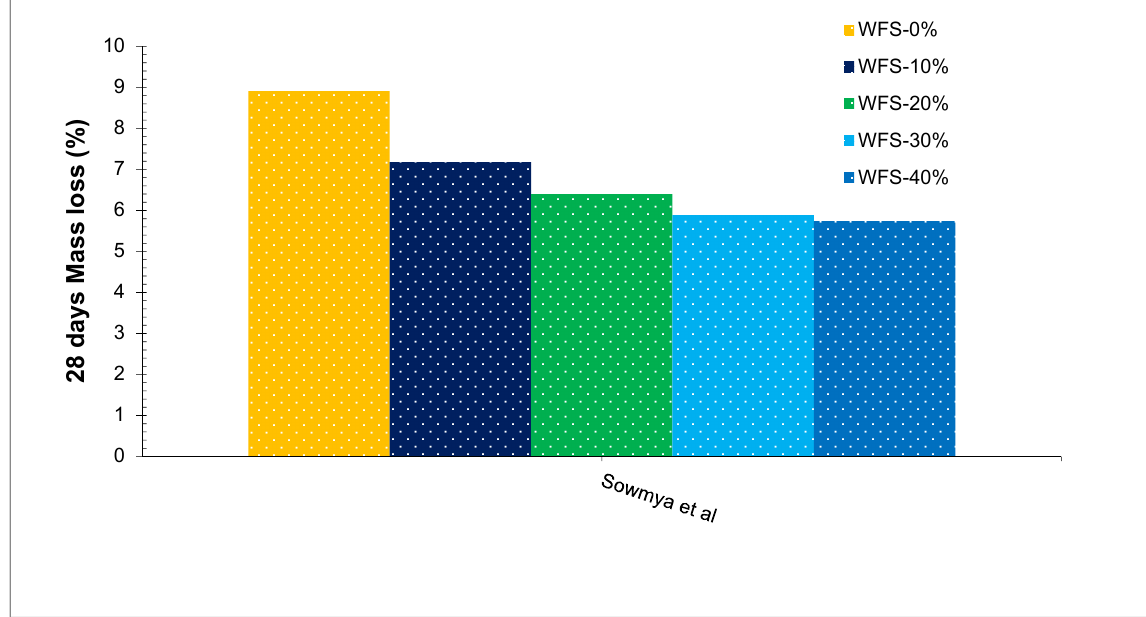
Figure 9. Acid Resistance at 28 days [56].